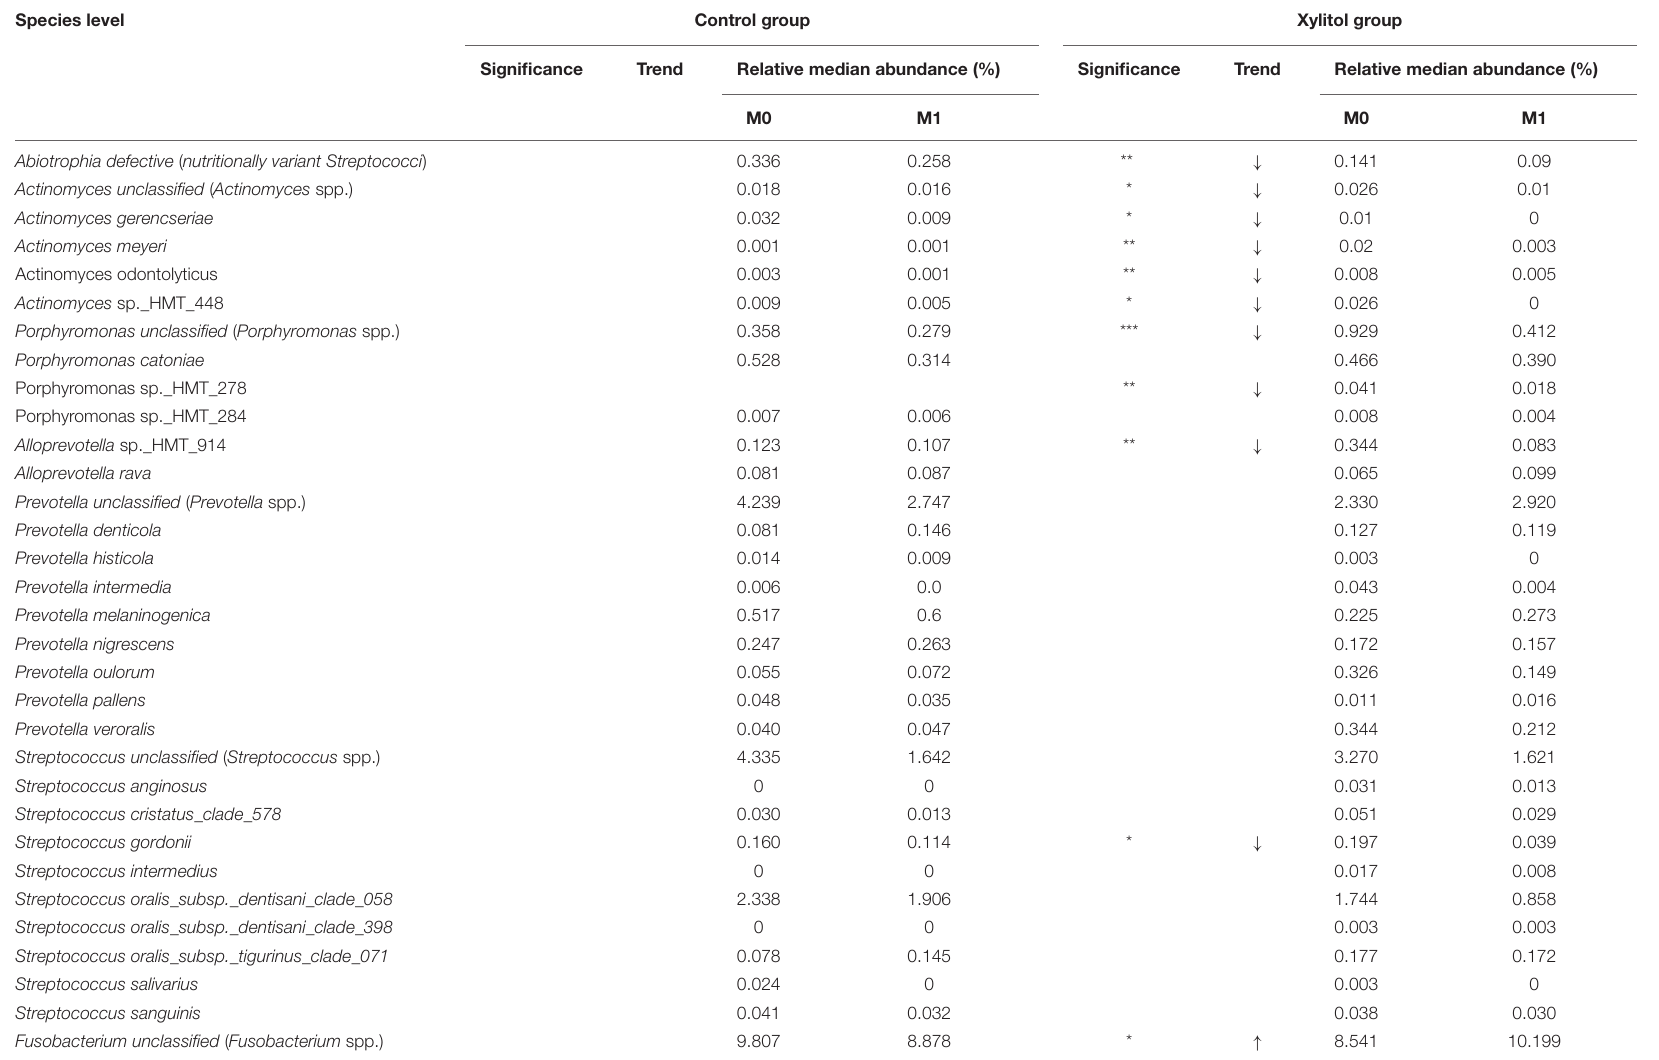
TABLE 3 | Detection selected abundance of Abiotrophia , Actinomyces , Porphyromonas , Alloprevotella , Porphyromonas , Streptococcus , Fusobacterium , and Leptotrichia species carried by control and xylitol